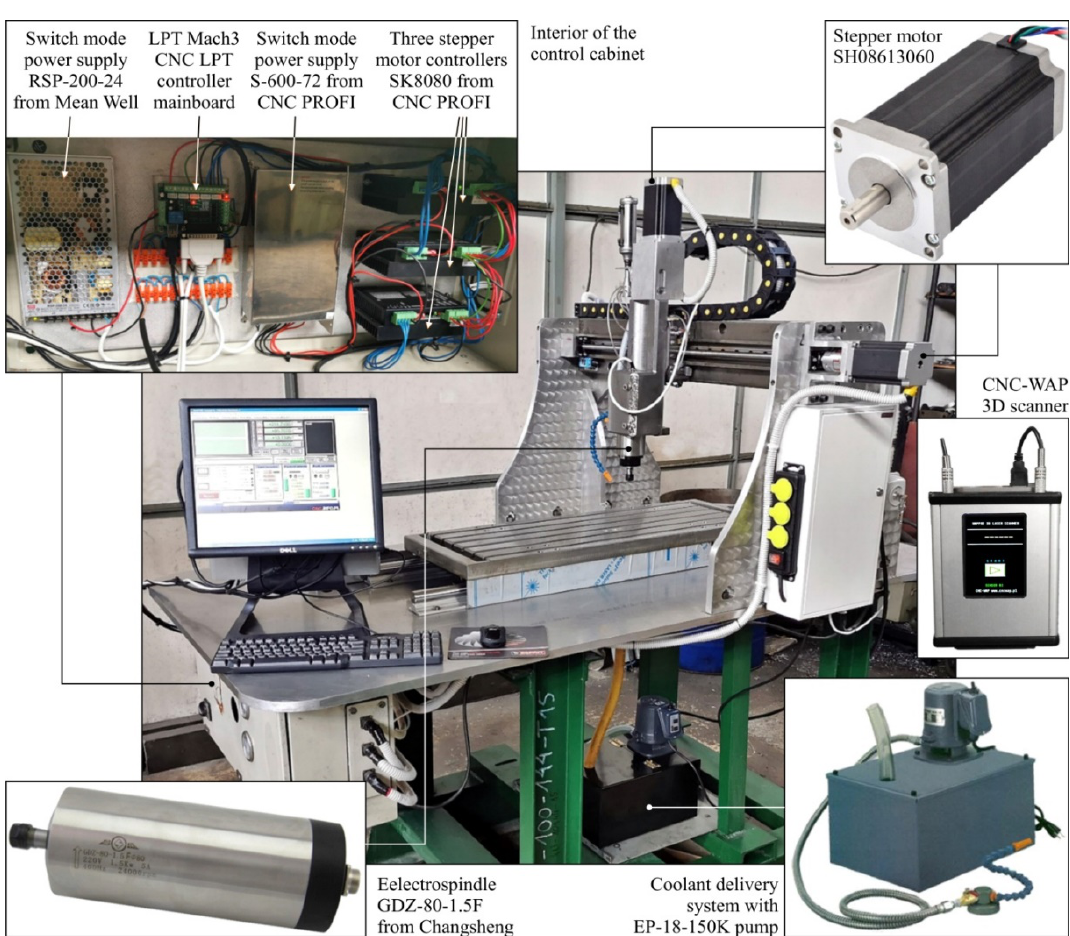
Figure 2. General view and key components of the prototype machine tool integrating 3D scanning, milling, and grinding of shaped surfaces.